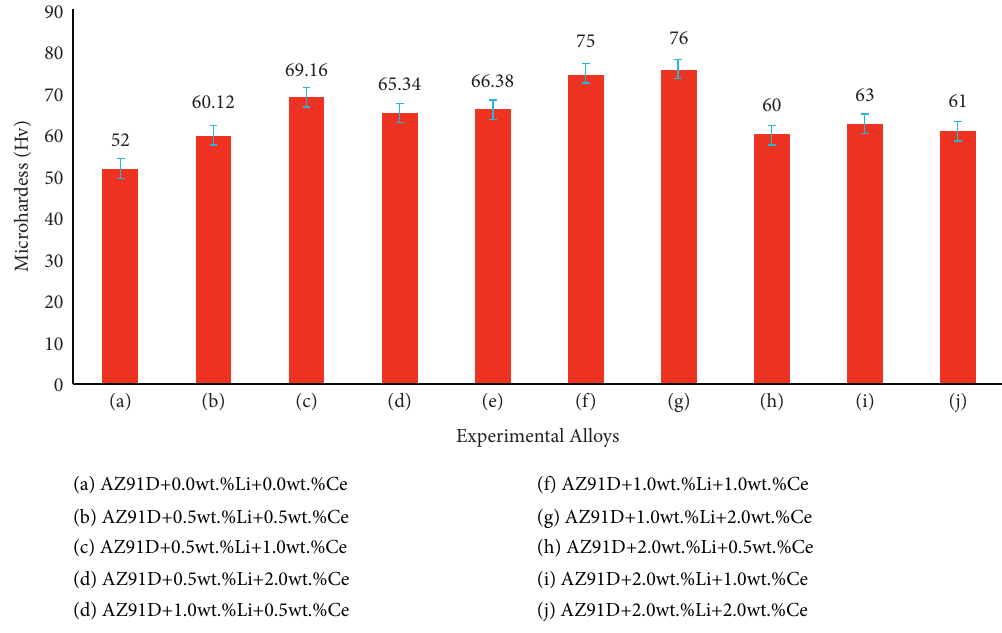
Figure 9: Microhardness results. Table 2: Corrosion Rates for different experimental alloys.